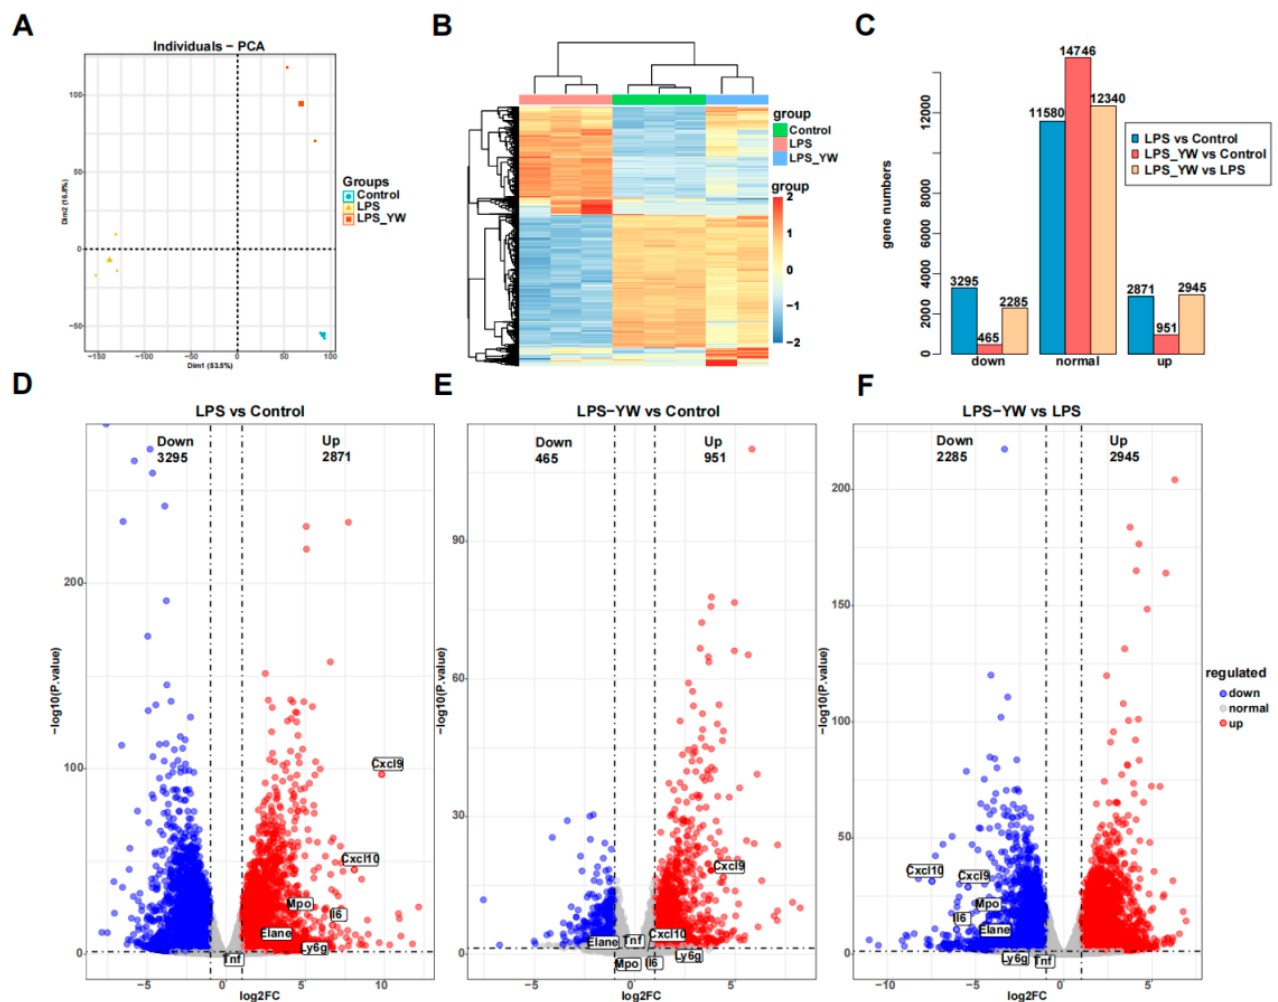
Figure 5. RNA-seq data analysis of lung tissues of mice from different treatment groups. ( A ) Principal component analysis found that there was no overlap between the three groups (Control group, n = 3; LPS group, n = 3; LPS/YW3-56 dual-treatment group, n = 2). ( B ) Hierarchical clustering of the 1000 most variable genes also demonstrated clear separation of three group of samples. ( C , D ) Differential expression analysis identified significant numbers of differential expressed genes in LPS relative to control samples (total 6166 genes with 2871 upregulated and 3295 downregulated). ( C , E ) Less numbers of differential expressed genes (1416 genes) in LPS and YW3-56 dual treatment relative to control samples were found, of which 951 genes were upregulated and 465 genes were downregulated. ( C , F ) 5230 of differential expressed genes in LPS and YW3-56 dual treatment relative to LPS treatment samples were found, of which 2924 genes were upregulated and 2285 genes were downregulated. PCA, principal component analysis; log2FC, log2 fold change; LPS, lipopolysaccharides treatment gruoup, LPS_YW, LPS and YW3-56 dual-treatment group. To further identify the genes whose upregulated expression induced by LPS was re- versed by YW3-56, a total of 1789 genes were obtained from the intersection of upregu- lated genes in LPS compared to control samples and downregulated genes of LPS/YW3- 56 dual treatment compared to LPS groups (Figure 6A). Gene ontology enrichment anal-